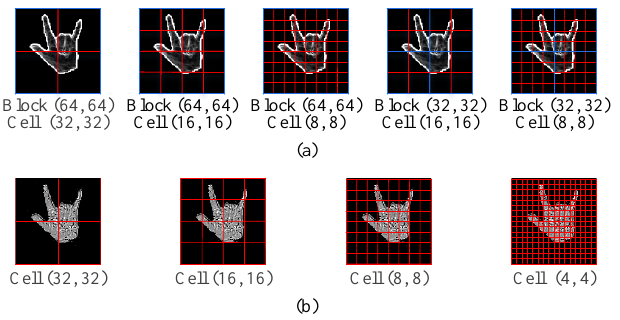
Figure 9. ( a ) Different size models of HOG. ( b ) Different size models of 9ULBP.